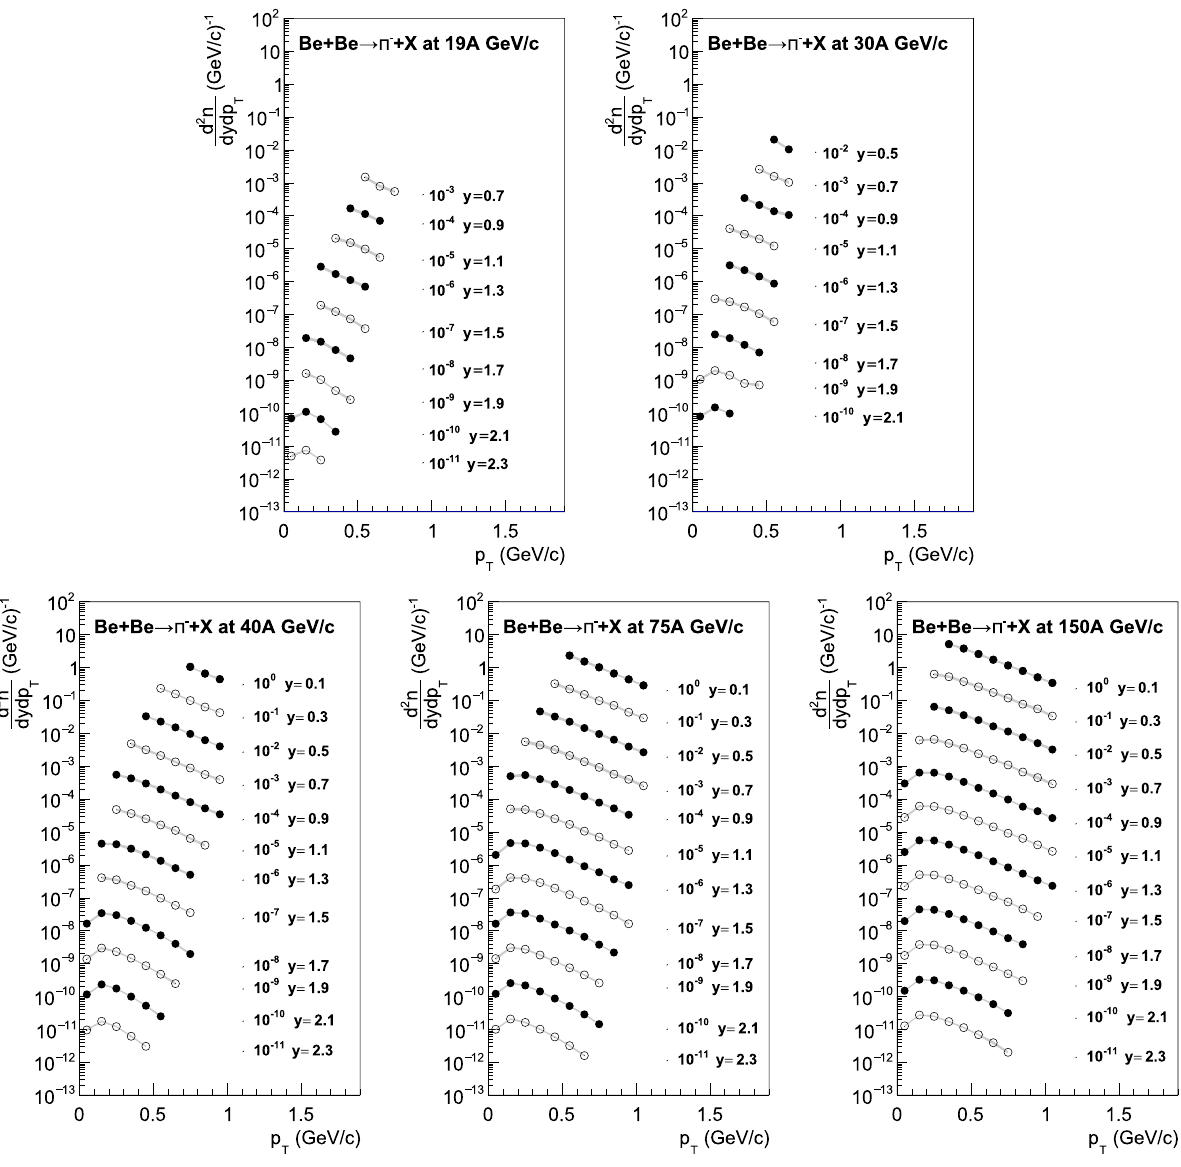
Fig. 23 Transverse momentum spectra in rapidity slices of π − pro- duced in the 20% most central Be+Be collisions. Rapidity values given in the legends correspond to the middle of the corresponding inter-